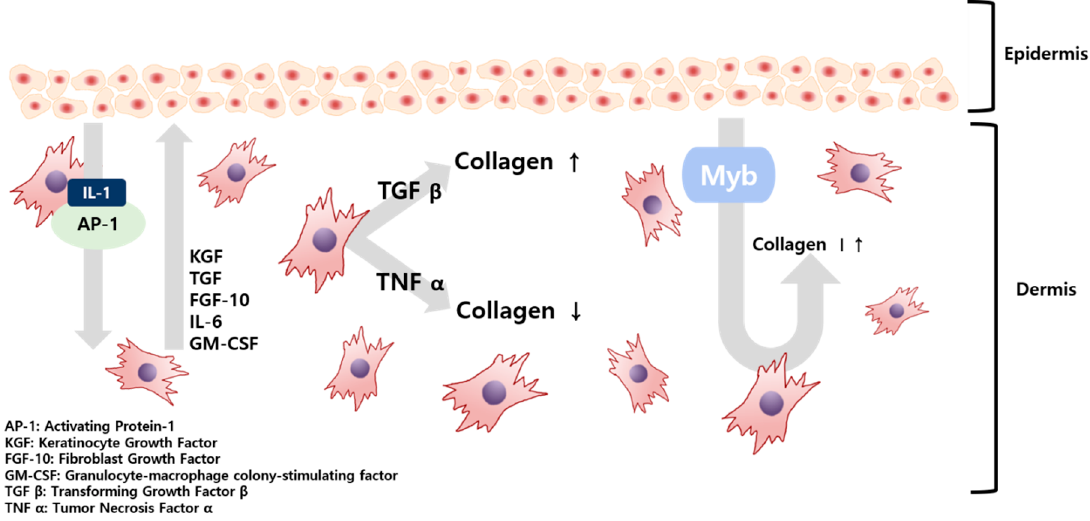
Figure 1. Schematic illustration of the paracrine signaling between fibroblasts and keratinocytes in the skin tissue.